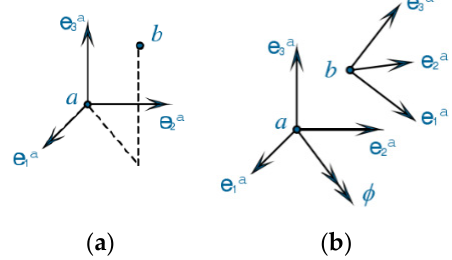
( b ) Figure 14. Specimens of CFS shear walls with SPR (mm): ( a ) W-1, ( b ) W-2. 5.2. Finite Element Models of CFS Shear Wall with SPR For the CFS shear wall with SPR, the geometric model of each component was estab- lished, and S4R shell element was used for the CFS frame and sheathing. The position of the SPR connection was divided to obtain corresponding nodes, and the mesh of compo- nents was formed after assembly. The mesh size of the CFS frame was 10 mm and the mesh size of the steel sheathing was set to 20 mm. The established finite element models were FW-1 and FW-2, which correspond to the test specimens W-1 and W-2, respectively.